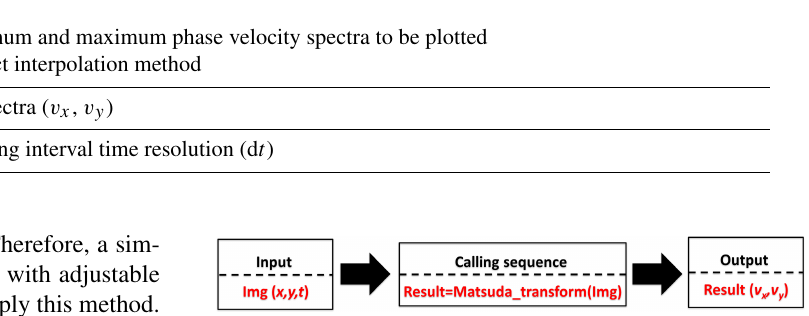
Figure 1. Flow chart showing the input, how to run the program, and the output